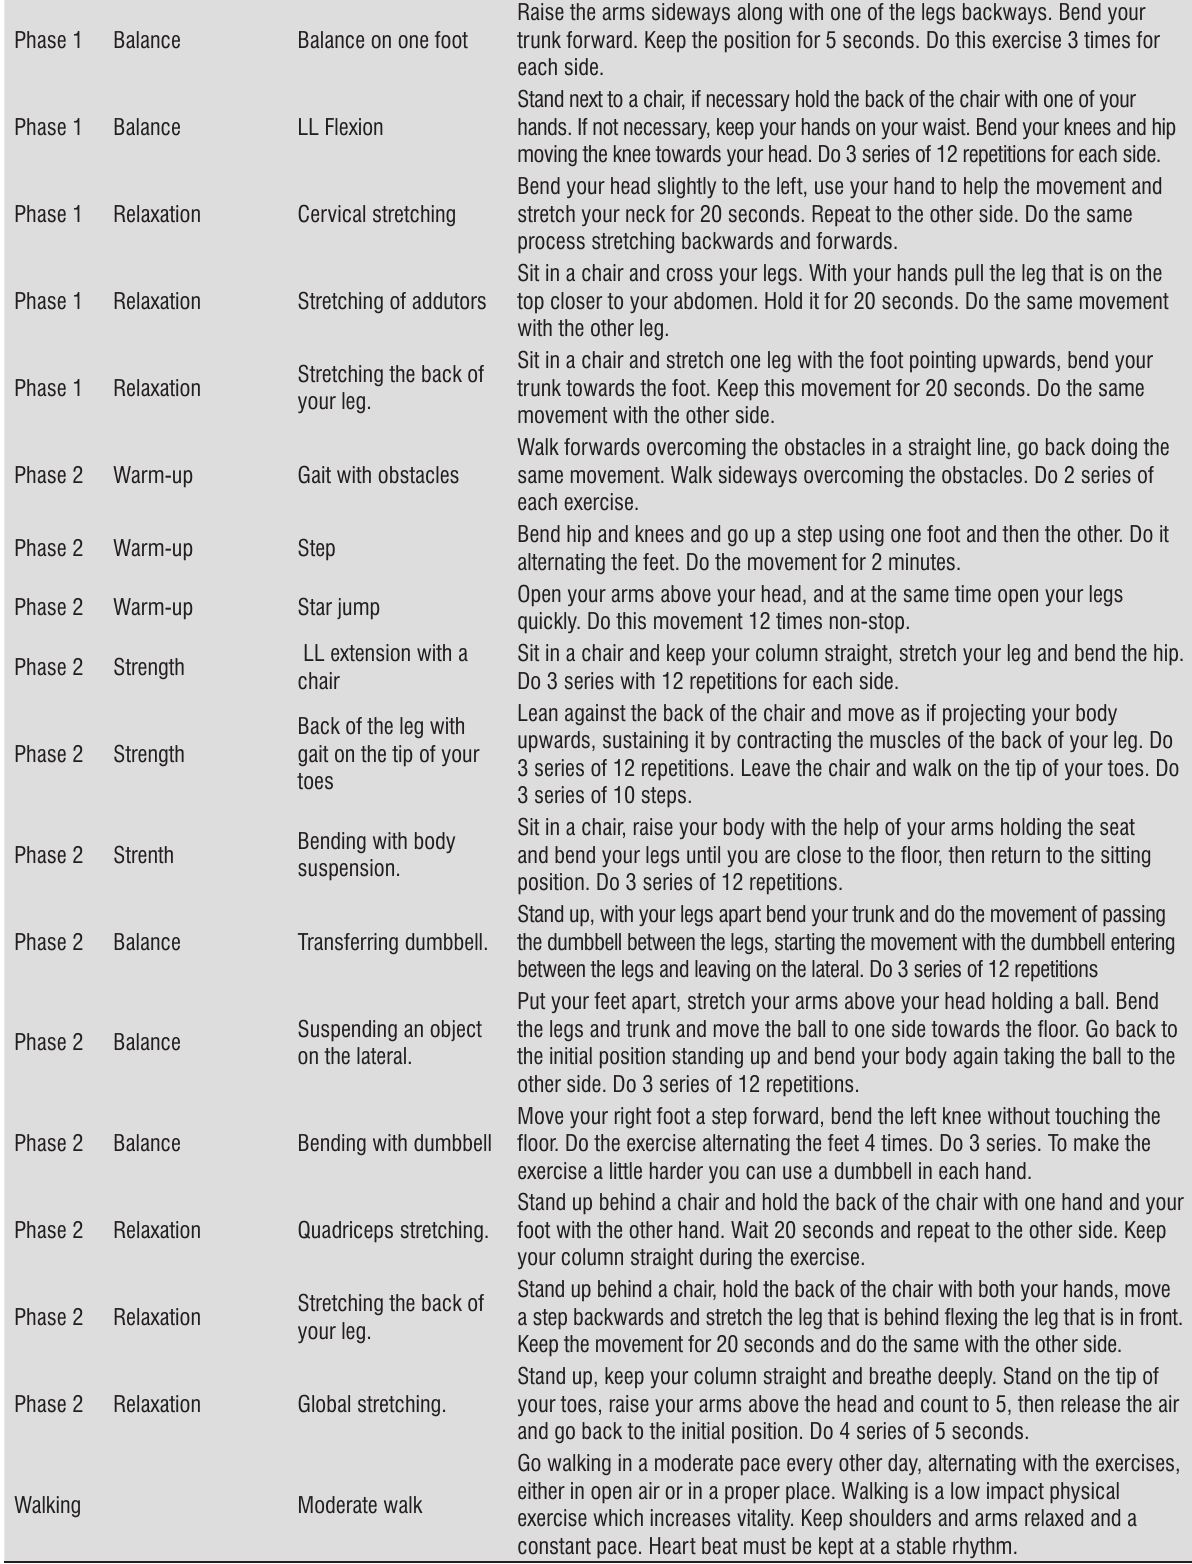
Table 1 - Exercises selected after survey of clinical